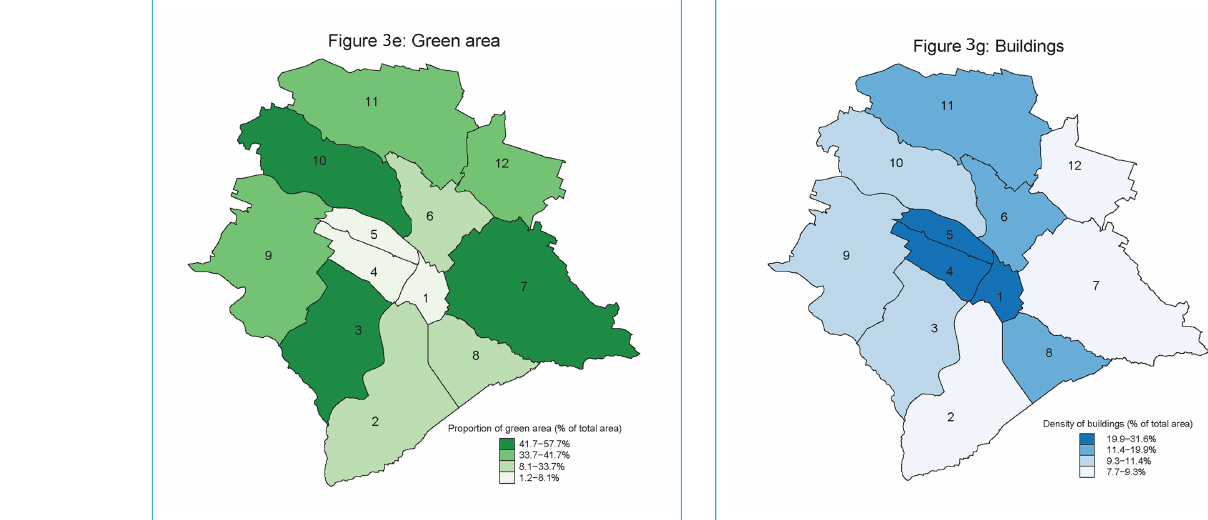
Figure 3g: Map of the City of Zurich showing building density in different districts (intensity of the colour symbolises the quantity of proportion; dark = high proportion, light = low proportion) (n = 7145).